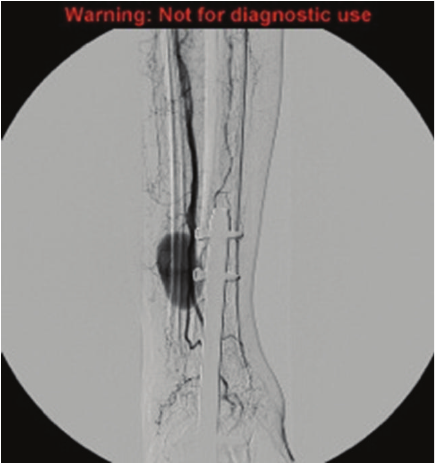
Figure 3: Following endovascular stenting, the artery is patent with no filling of the